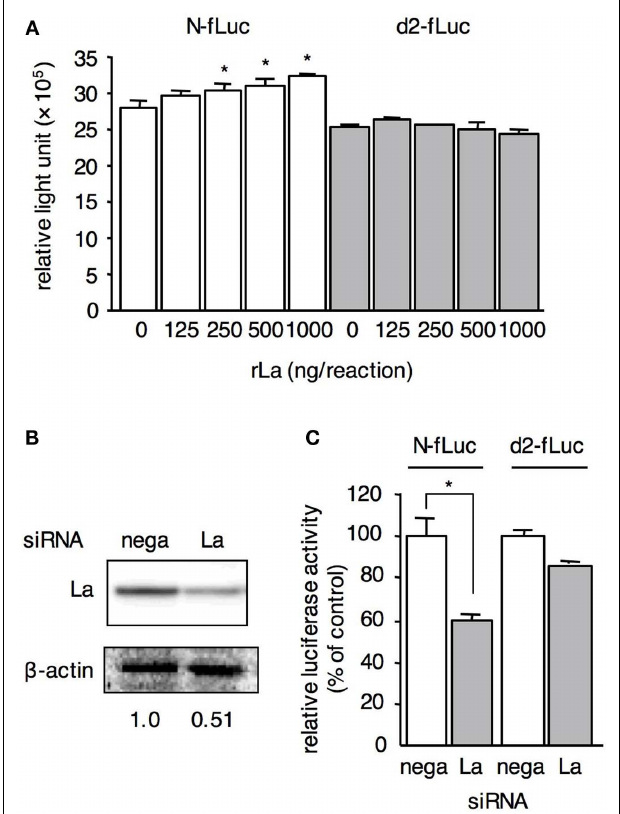
FIGURE 4 | Laenhances N-fLuc translation. (A) N-fLuc and d2-fLuc were translated in COBL-a S10 cell extracts with rLa at the indicated quantity. Statistical analysis was performed using the Student’s t -test; * P < 0.05. (B) Expression level of La in HepG2 cells transfected with La siRNA (La) or negative control siRNA (nega). After 48-h incubation, the expression levels of La and actin on the same membrane were detected by western blotting. The relative value of the La expression level was measured and is provided under the panels. (C) The translation of N-fLuc in La siRNA-transfected HepG2 cells decreased more than that in d2-fLuc.The luciferase activity in HepG2 cells transfected with negative control siRNA was arbitrarily set at